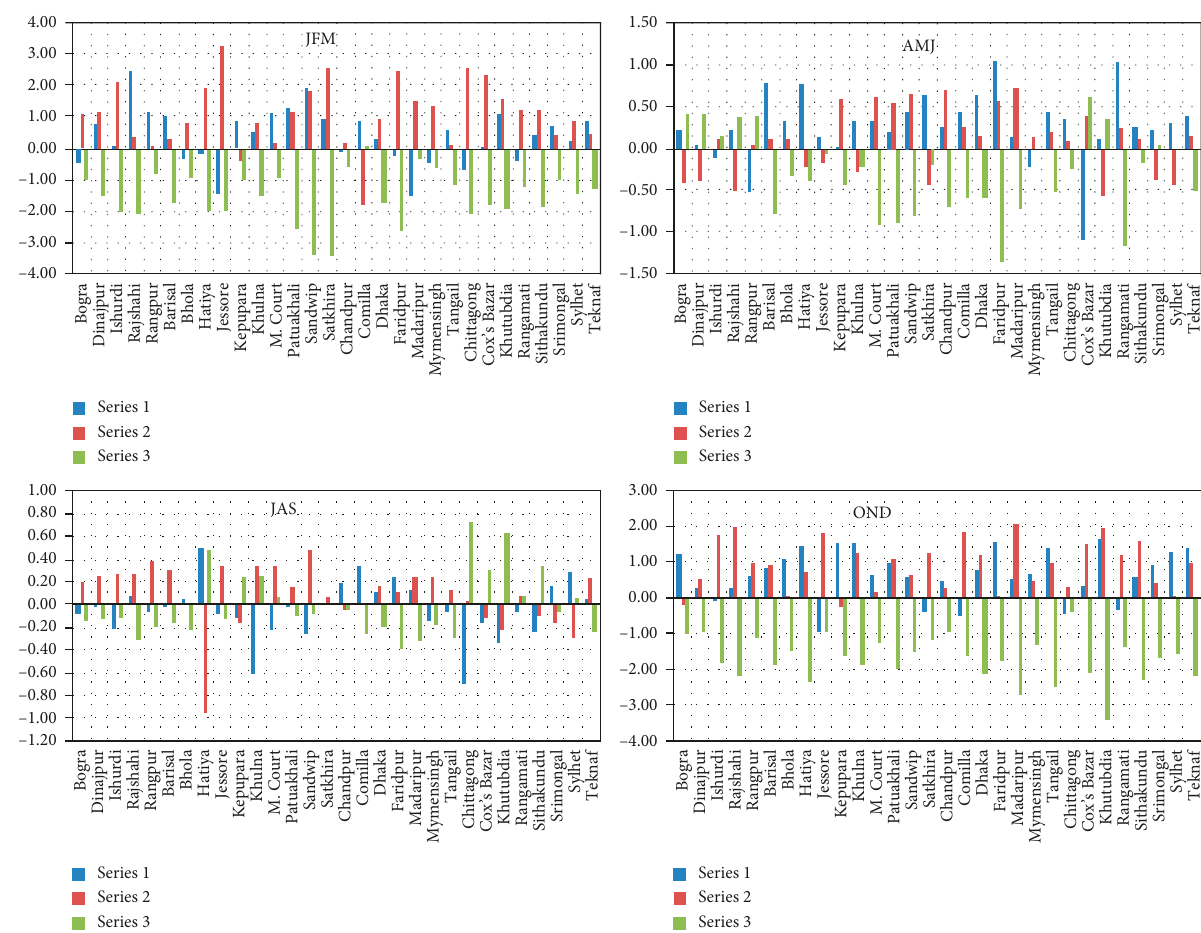
Figure 11: Three-month PCI changes in different periods from long-term mean PCI (1980–2011) (series 1 1990–1999, and series 3 (cid:31)